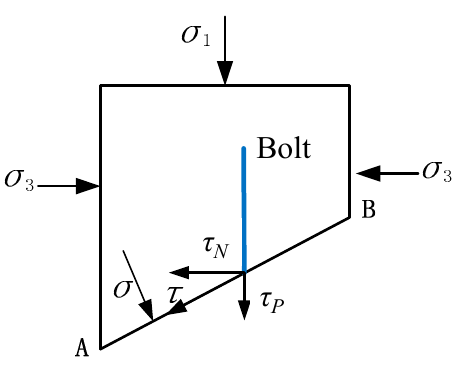
Figure 7. Mechanical model with the slipping of fracture rock supported by a bolt.